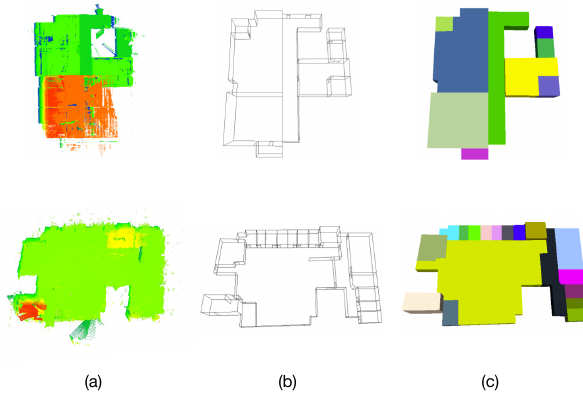
Figure 10. Experiment results. From left to right: the original point clouds, wireframe models without ceilings, reconstruction models with ceilings.